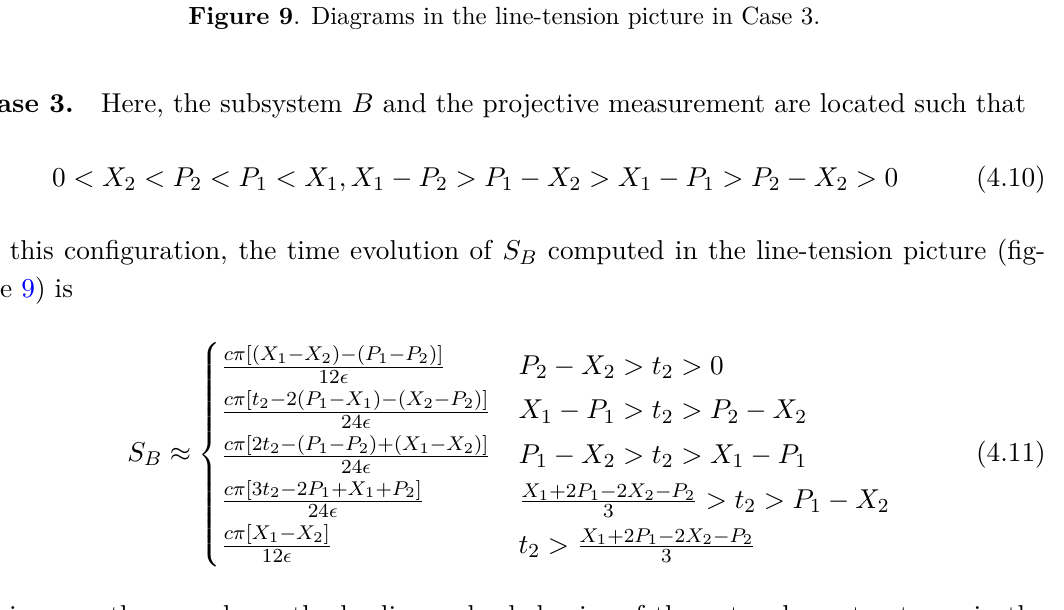
Figure 9 . Diagrams in the line-tension picture in Case